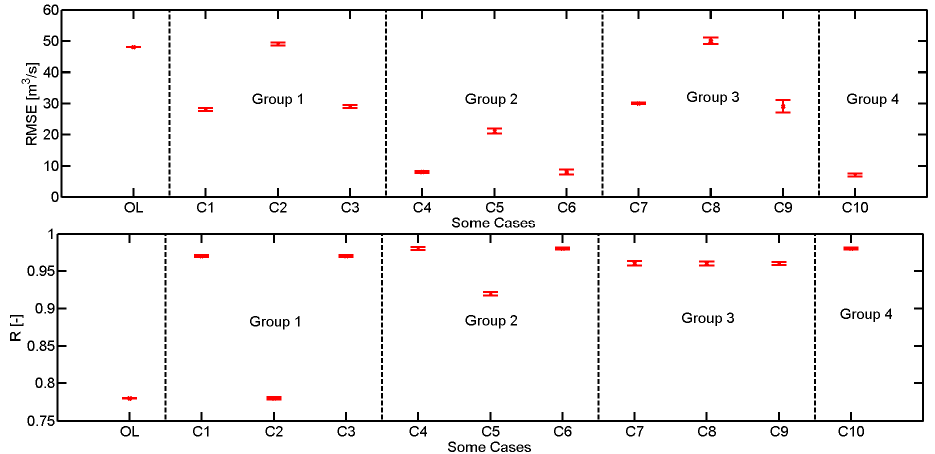
Figure 5. Daily streamflow flow RMSE and correlation ( R ) results for synthetic data assimilation experiments based on the application of the Open Loop (OL) HBV model (with no DA) and the 10 DA cases (C1 to C10) outlined in Section 2.6 and Figure 1.